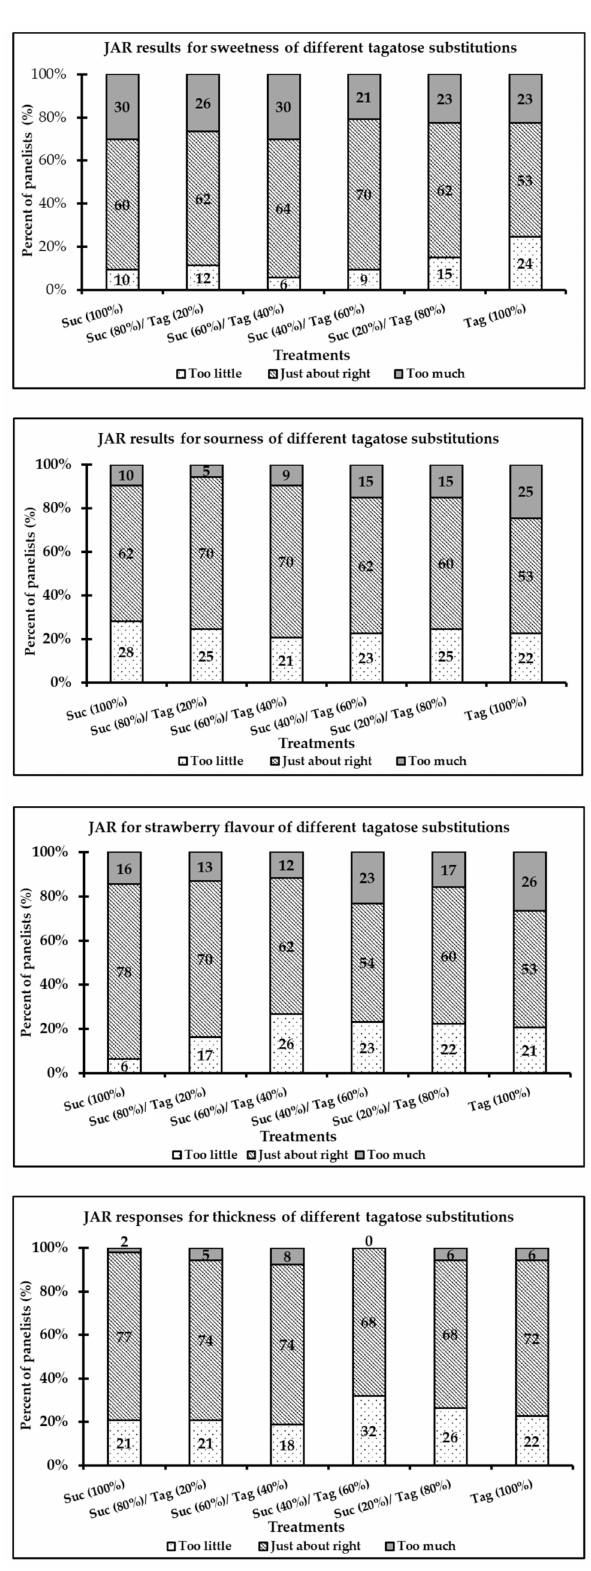
Figure 2. Selection frequencies (%) of the just-about-right (JAR) results in overall taste liking for sweetness, sourness, strawberry flavor, and thickness of strawberry-flavored yogurt samples (treatment labels are shown in Table